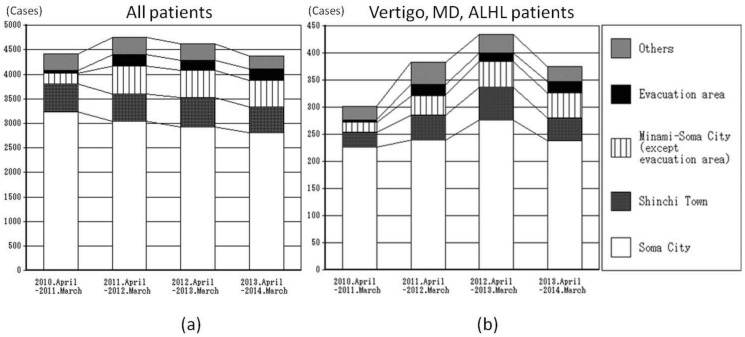
Investigation of the new ENT patients from April to the following March by living area.(a) For all new patients, the number from Soma City decreased, but that from Minami-Soma City and other evacuation areas increased. (b) Those with vertigo, MD, and ALHL increased in each area. In Soma City and Shinchi Town, the number peaked in the second year and showed a slight decrease in the third year. On the other hand, the number of new patients in Minami-Soma City and the evacuation areas remained about the same.